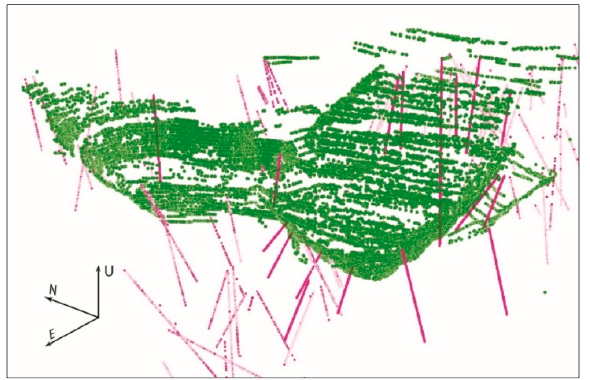
Figure 4. The 3-D schematic representation of the structural database acquired for the Los Bronces mine. Green dots show slope mapping data and magenta dots indicate drill-hole mapping information.